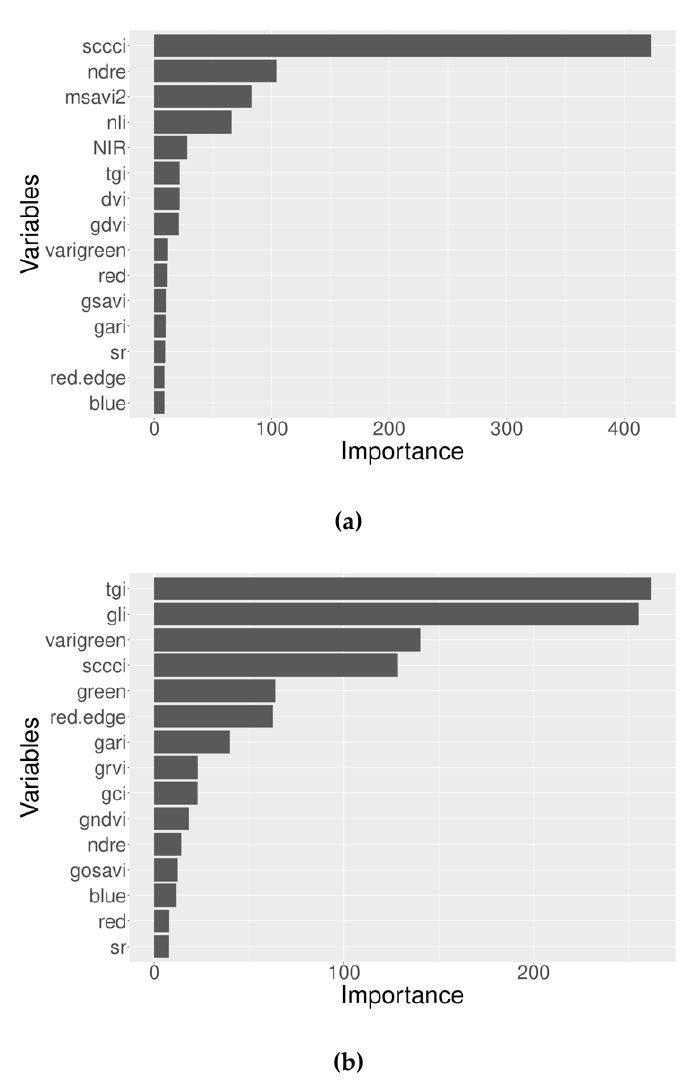
Figure 8. Feature importance by Random forest feature selection method: ( a ) at V4-5; ( b ) at VT.